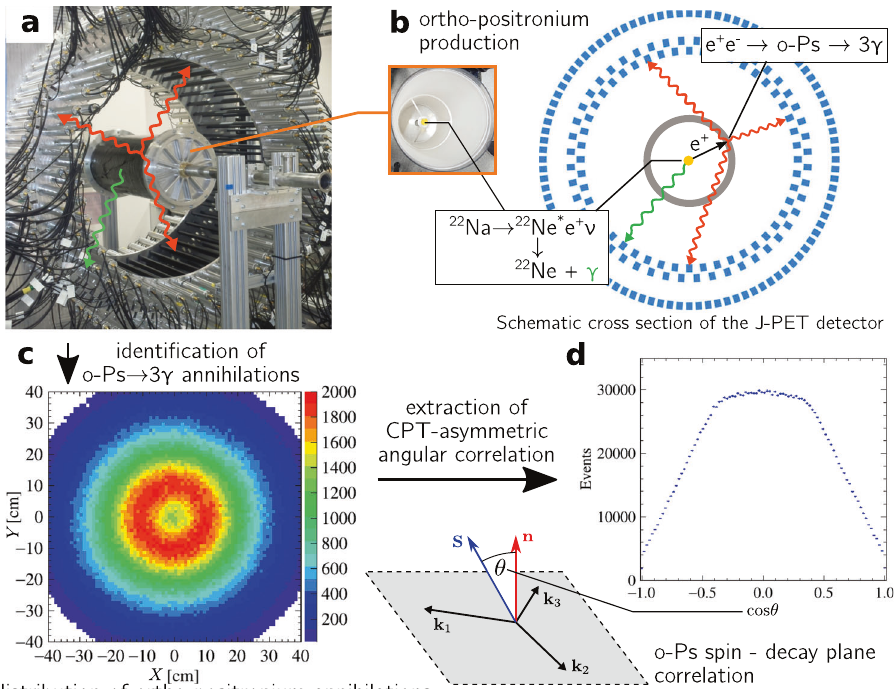
Fig. 1 Methodology of the measurement of CPT-violation-sensitive angular correlation in three-photon annihilations of ortho-positronium. a Photograph of the J-PET tomograph with the cylindrical positronium production chamber. Plastic scintillators (black strips) record photons produced in o-Ps → 3 γ events (red arrows) and a prompt photon from β + emitter de-excitation (green arrow). b Photograph of the interior of the positronium production chamber and a schematic view of the transverse cross section of the J-PET tomograph. Plastic scintillators (with rectangular cross sections (blue)) form three coaxial rings. Annihilating o-Ps atoms are produced by positrons from a 22 Na β + source in the centre of a cylindrical vacuum chamber (grey), the walls of which are coated with porous silica, where positrons thermalise and form positronia. c Reconstructed spatial locations of the identi fi ed o-Ps → 3 γ events obtained using three-photon annihilations, allowing us to reproduce a tomographic image of the vacuum chamber. The maximum density distribution is in a ring with a radius of 12 cm, equal to the radius of the positronium production chamber. d For every selected event, the o-Ps spin axis is reconstructed, allowing calculation of the cosine of the angle between the spin ( S ) and annihilation plane orientation ( n = k 1 × k 2 ), the distribution of which is sensitive to CPT-violating asymmetries. The histogram presents the determined cos θ distribution for 1.9 × 10 6 identi fi ed o-Ps → 3 γ